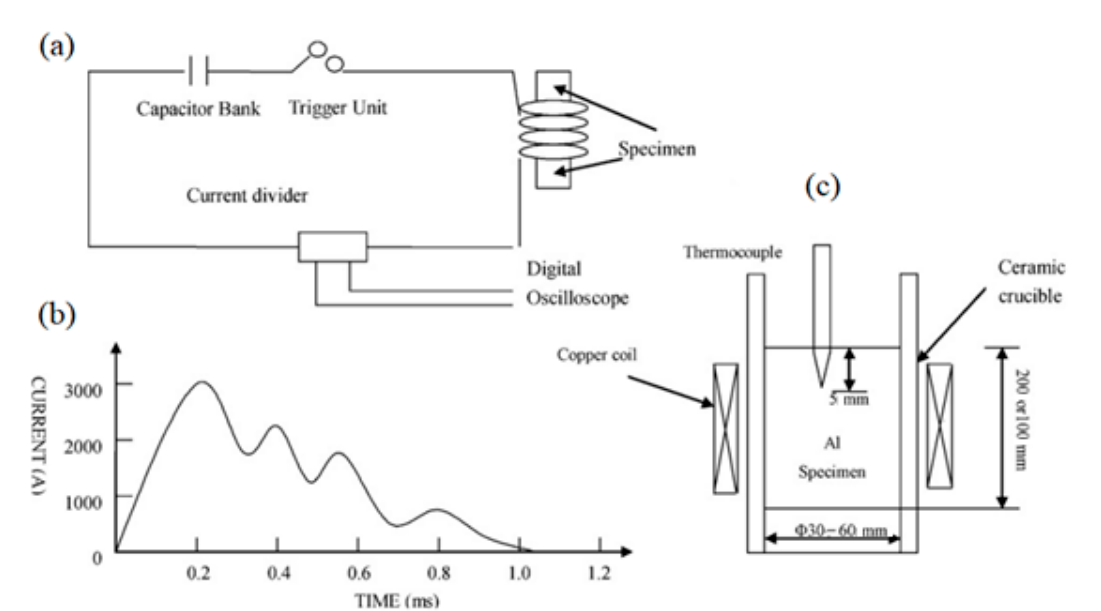
Figure 7. ( a ) Installation schematic diagram. ( b ) The current pulse’s profile (when discharging a 2500 V current from the capacitor bank). ( c ) Scheme of the setup for magnetic field treatment melts [20]. Copyright 2008, Elsevier.